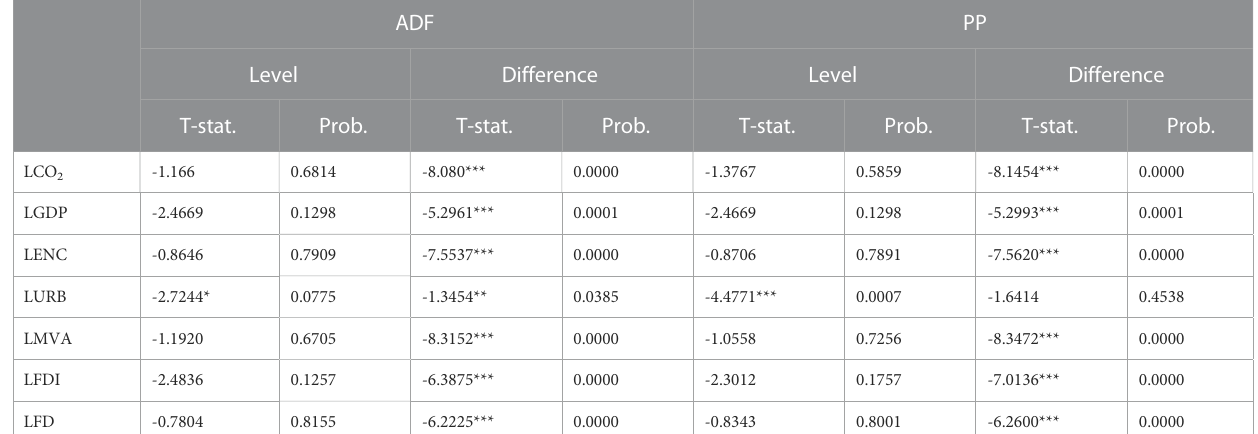
TABLE 3 ADF and PP